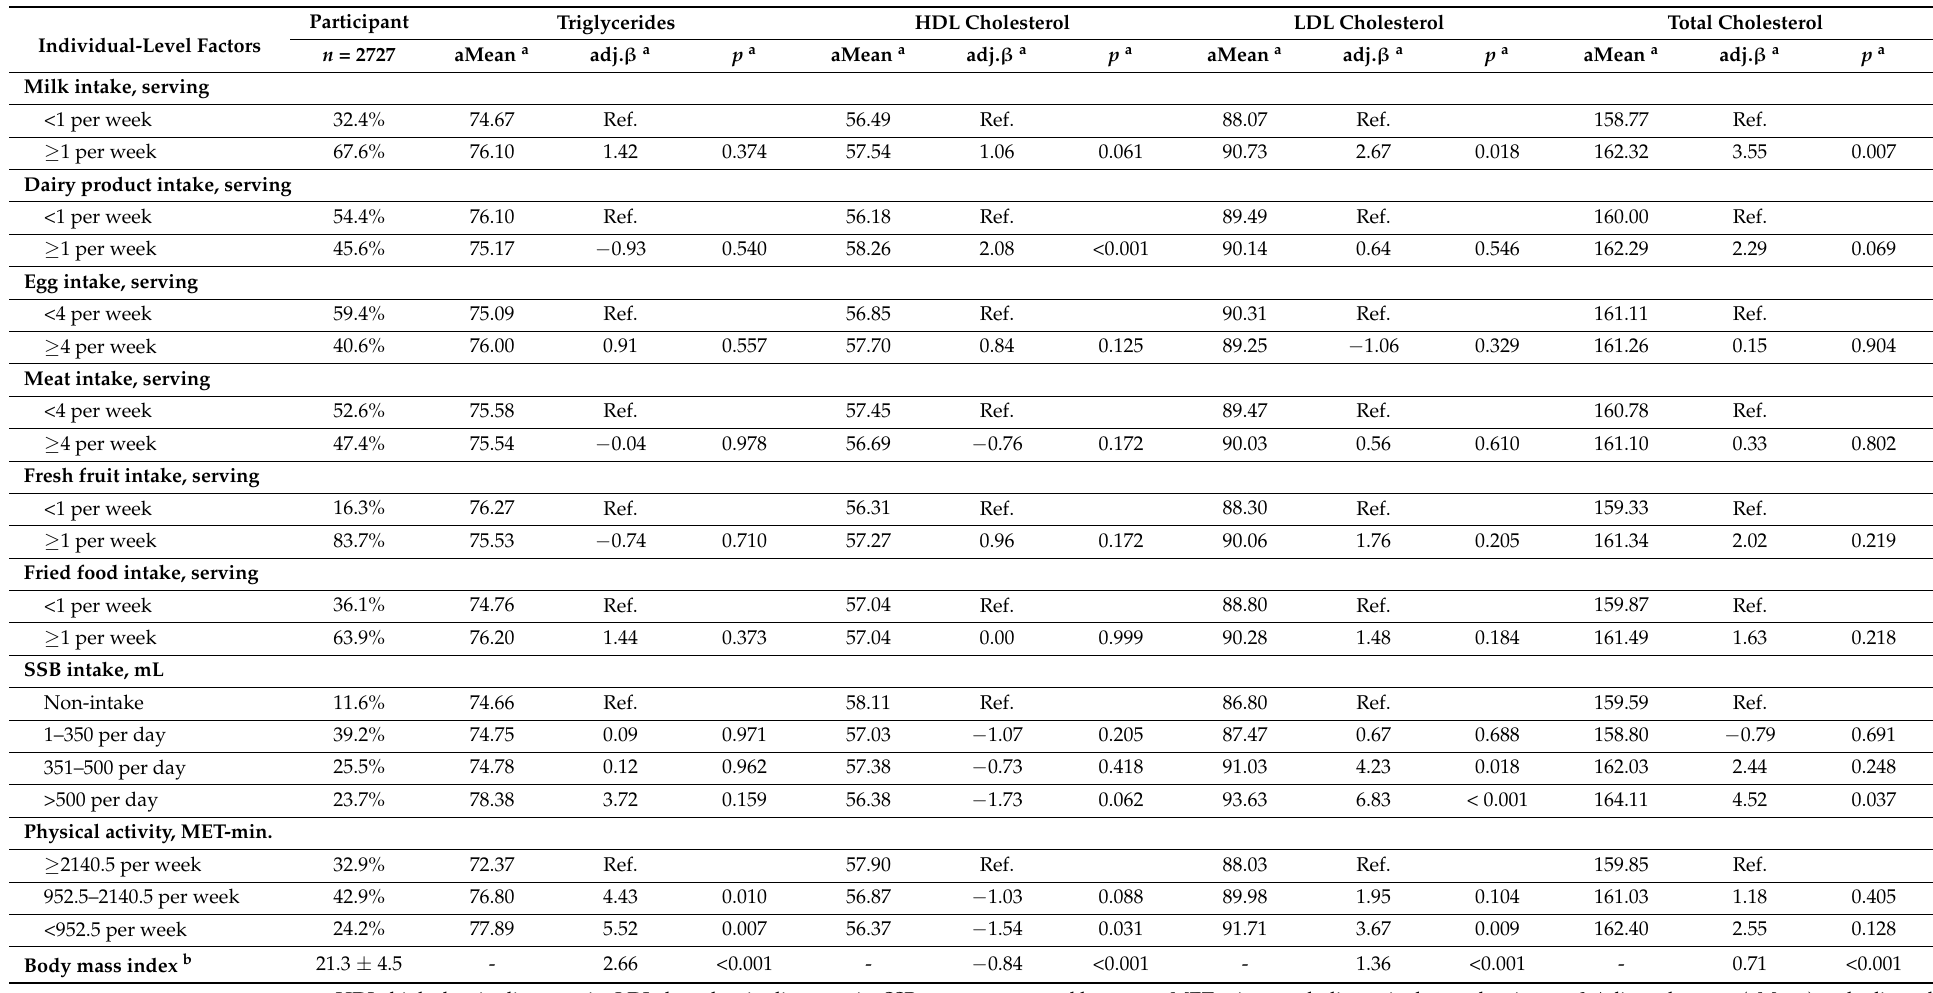
Table 2. The adjusted effects of individual-level factors on lipid profile (mg/dL) in